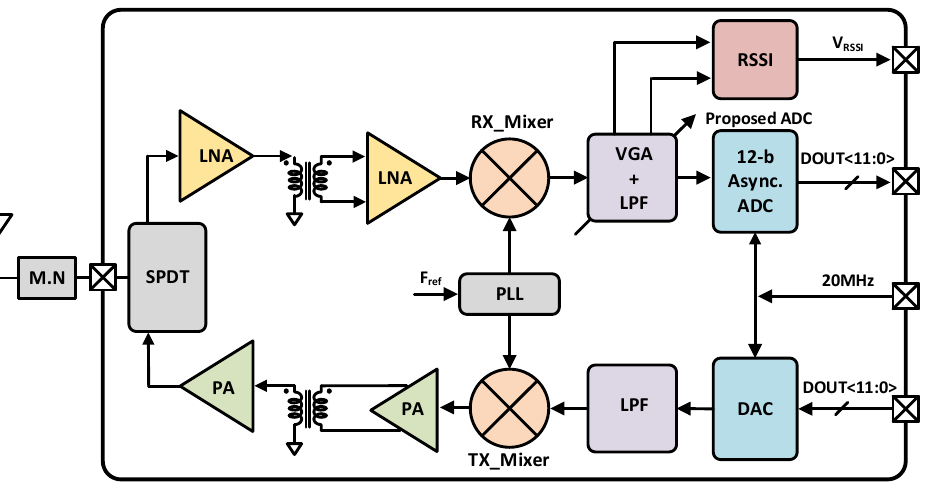
Figure 1. Top architecture of the DSRC transceiver.